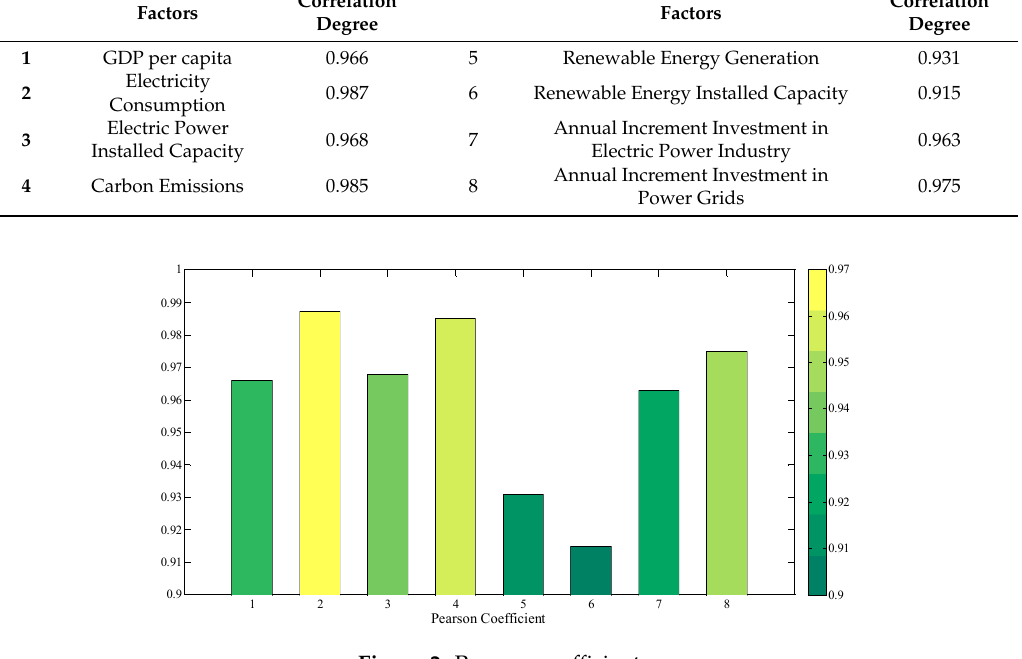
Figure 2. Pearson coefficient.